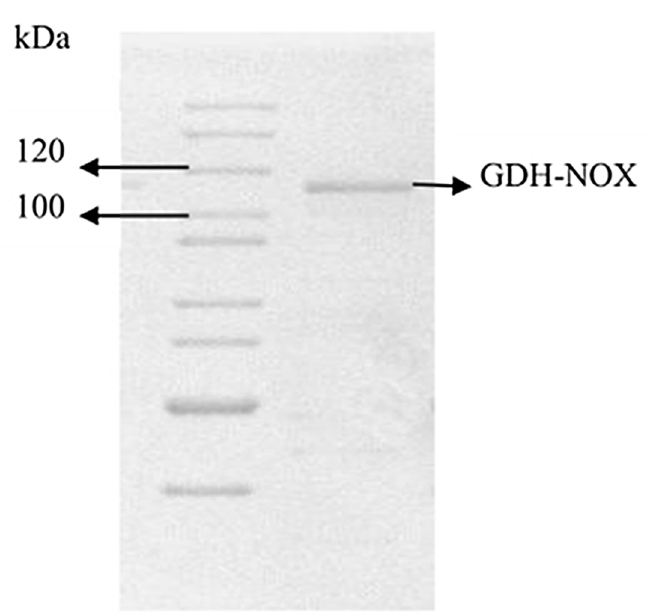
Fig 7. 10% SDS-PAGE analysis of the purification fused GDH-NOX. Line 1: protein marker; Lane 2: purified GDH-NOX with His-tag.